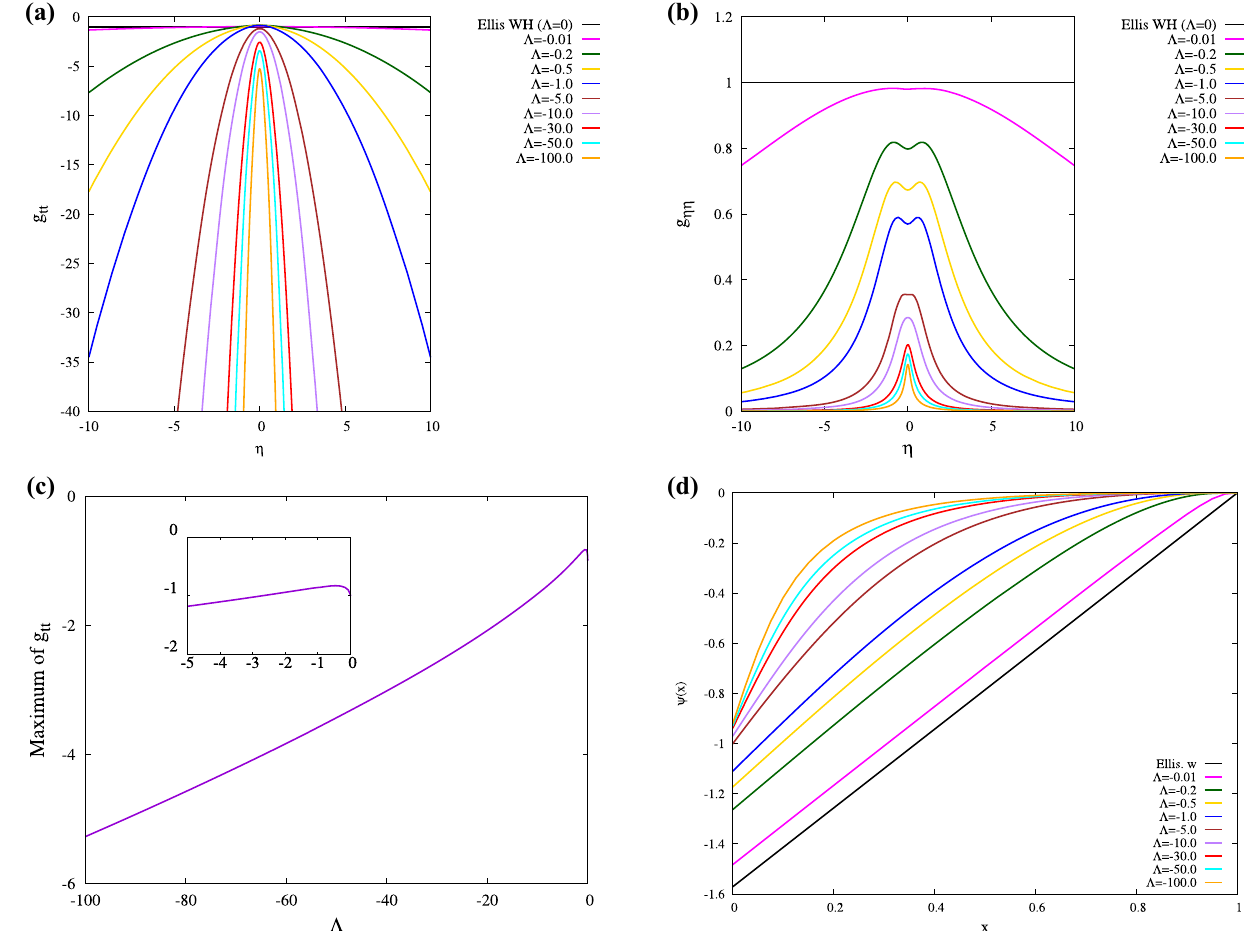
Fig. 1 Metric functions a g tt and b g ηη vs. the radial coordinate η for − 100 ≤ (cid:3) ≤ 0; c global maximum of g tt vs. the cosmological constant (cid:3) ; d phantom field function ψ( x ) vs. the compactified coordinate x for − 100 ≤ (cid:3) ≤ 0 (cid:3) = 0, D represents the phantom field charge, which is